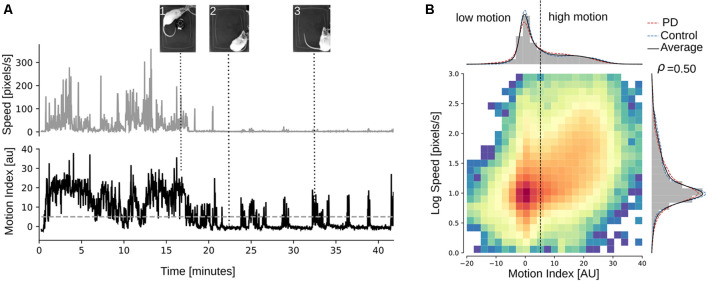
Accelerometry-derived motion-index (MI) detects motor activity accurately and is positively correlated to the speed of the rat. (A) Example of the speed (top panel) and the motion-index (bottom panel) of a bilateral 6-hydroxydopamine (6-OHDA) lesioned rat for 40 min. The pictures on top correspond to the rat in the open field at the moment indicated by the dotted lines. In the first half of the session (0–20 min approx.), the rat is navigating the open field, which is apparent in both the speed and the motion-index traces. But in the second half of the recording, according to the speed trace, the rat is not moving in the open field, but it is not entirely still, as can be observed in the pictures 2 and 3, and importantly, in the motion-index trace, which detects the exact moments when the rat perform head or body movements in place which do not result in navigating in the field. The gray dotted line represents the threshold for low/high motion-index as established next. (B) At the center, we show the 2D histogram of the speed in logarithmic scale (y-axis) and the motion-index (x-axis) generated by normalizing the distributions of each animal by aligning the first peak of the motion index (peak = −162.02 ± 6.02, mean ± standard deviation) to zero and the peak of log speed (peak = 0.7 ± 0.34) to one, for all the animals in the sample (n = 10 bilateral rats). The color scale of the histogram is normalized to a logarithmic scale to better visualize the positive correlation (Spearman’s ρ= + 0.50). At top and right, normalized histograms and Gaussian kernel density estimation (KDE; Scott’s rule bandwidth = 0.1) for both speed (right) and motion-index (top). Notice the bimodal distribution of the motion index, which can be separated in low/high states approximately at normalized index value 4.2. In contrast, the distribution of speed is unimodal, concentrating its mass mainly in the center of the log speed distribution. The distributions separated by 6-OHDA and sham are also included (dotted red and blue traces).